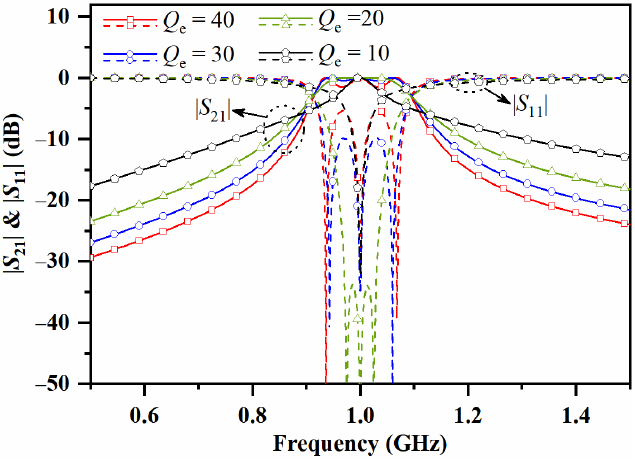
Figure 7. Theoretical curves for varying Q e considering m e1e1 = − m e2e2 = 0.15 and m oo = 0.